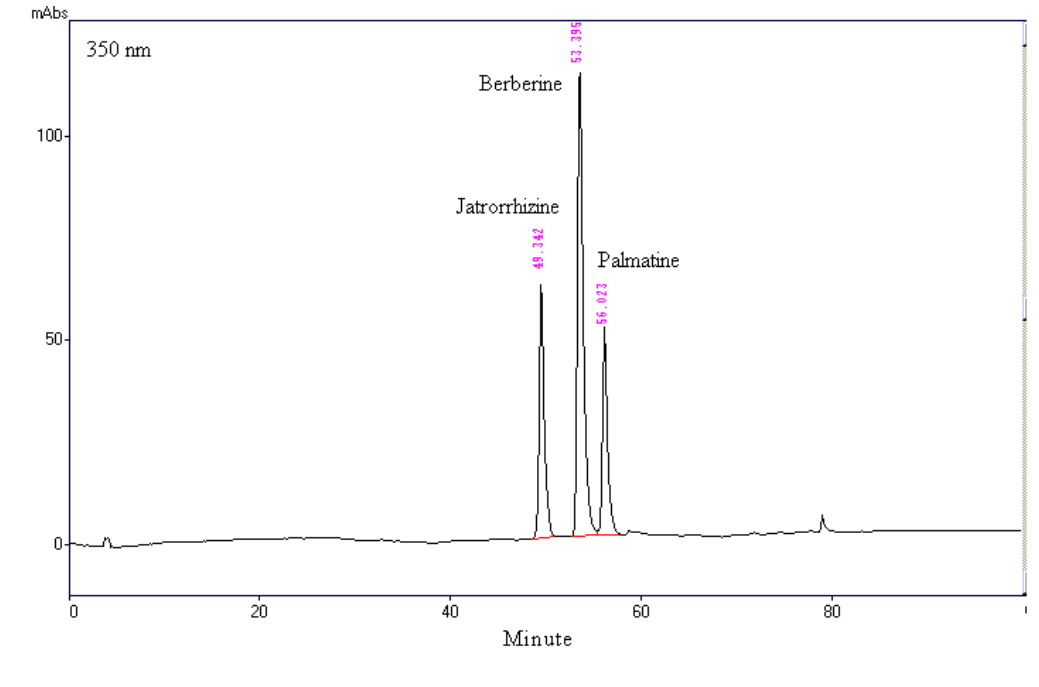
Figure 1. The HPLC chromatographic profile of MOS detection of jatrorrhizine, berberine and